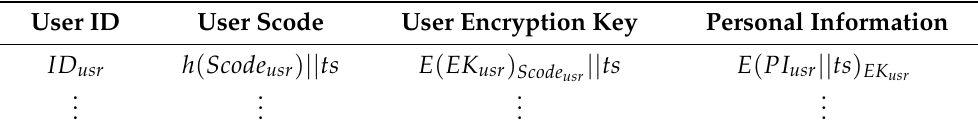
Table 1. An example of a table that stores user information in IoT devices.